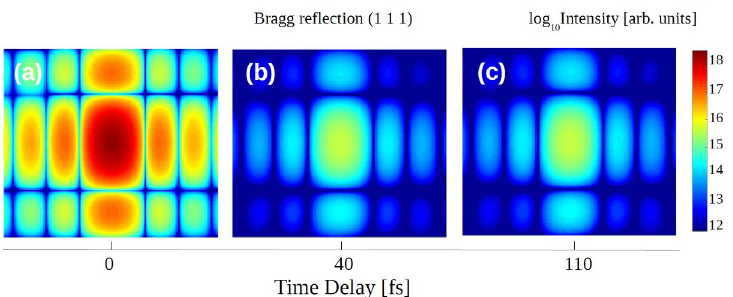
Figure 2. Contour plot for the Bragg reflection (1 1 1) in the (Q x , Q y ) plane in reciprocal space for 1.0 × 10 13 ph /µ m 2